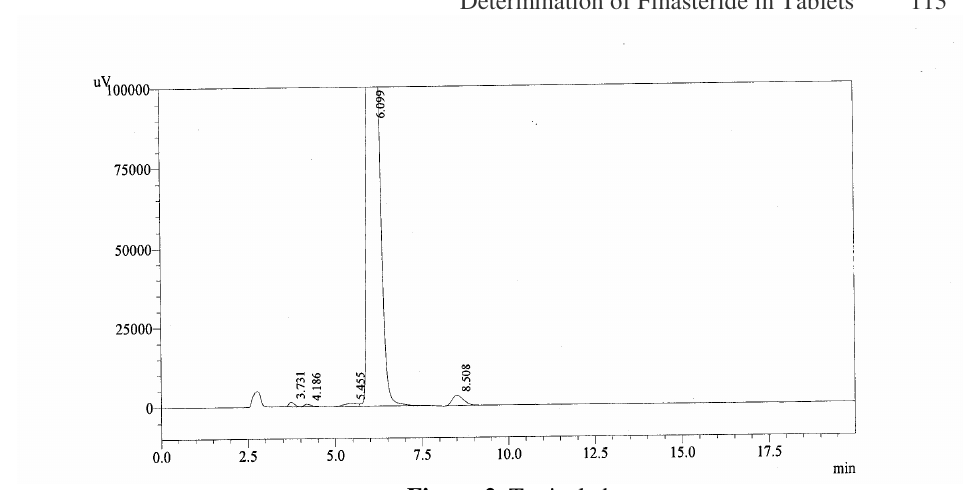
Figure 2. Typical chromatogram